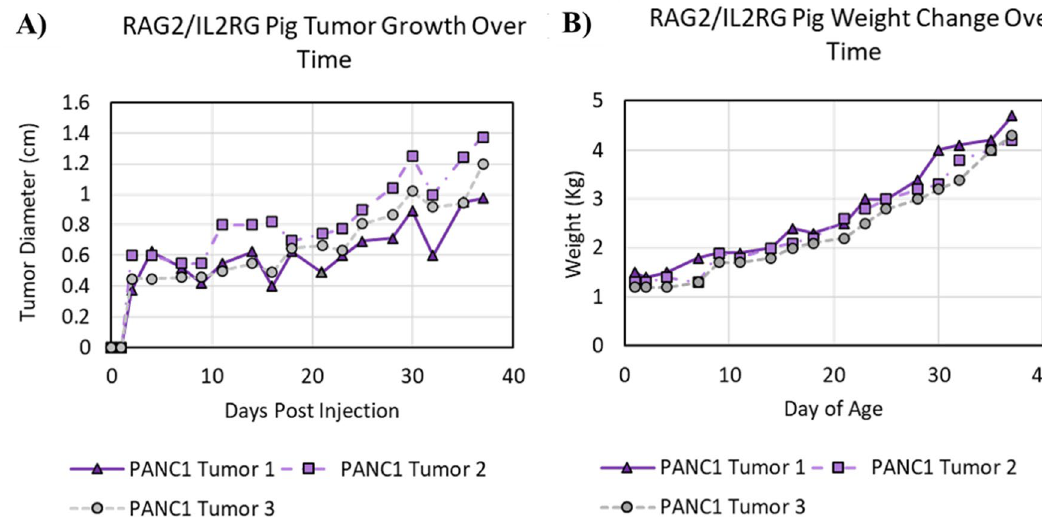
Figure 3. Successful engraftment of Panc01 cells. ( A ) Tumor growth was measured three times per week for each pig. All animals developed palpable tumors that continued to grow over the course of the study. ( B ) Pig weight was monitored throughout the duration of the study and utilized as a surrogate for animal morbidity.